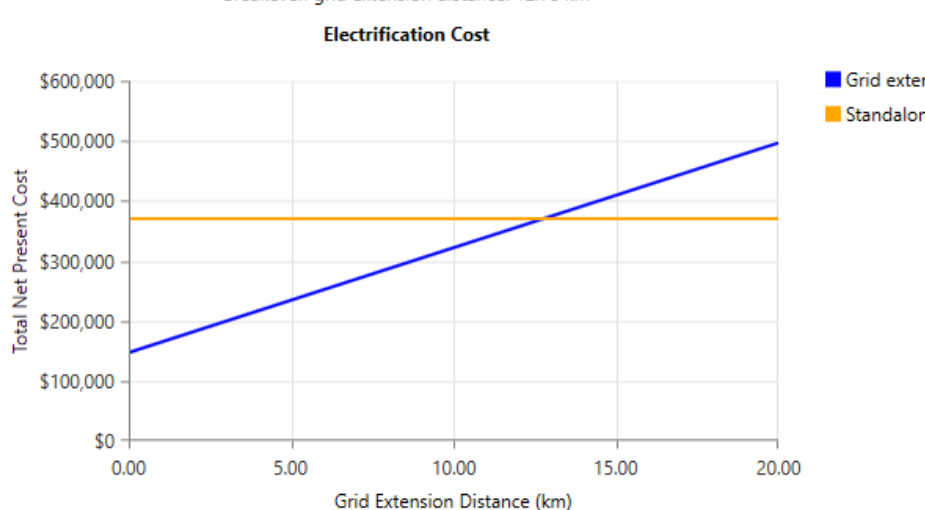
Figure 17. Cost of electrification options of Djoundé.